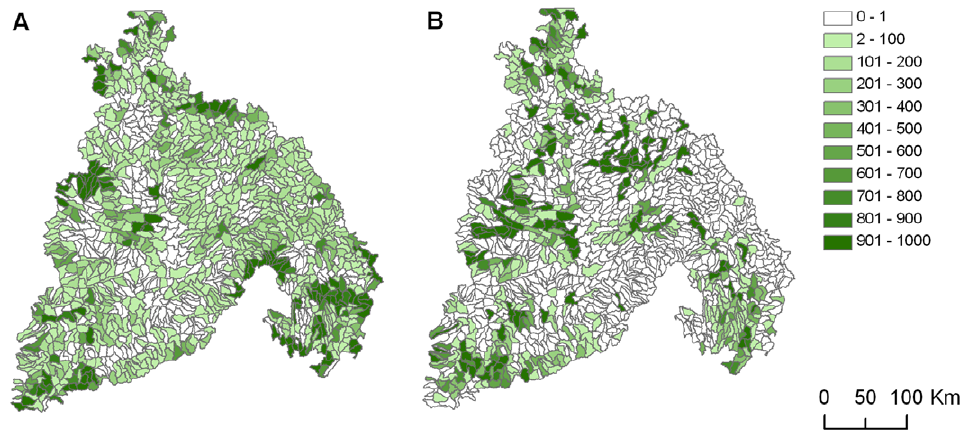
Figure 5. Irreplaceability of planning units. Irreplaceability is measured as the number of times a planning unit was selected across 1000 potential networks. Irreplaceablilty values are mapped for abiotic elements (A) and biodiversity elements (B).